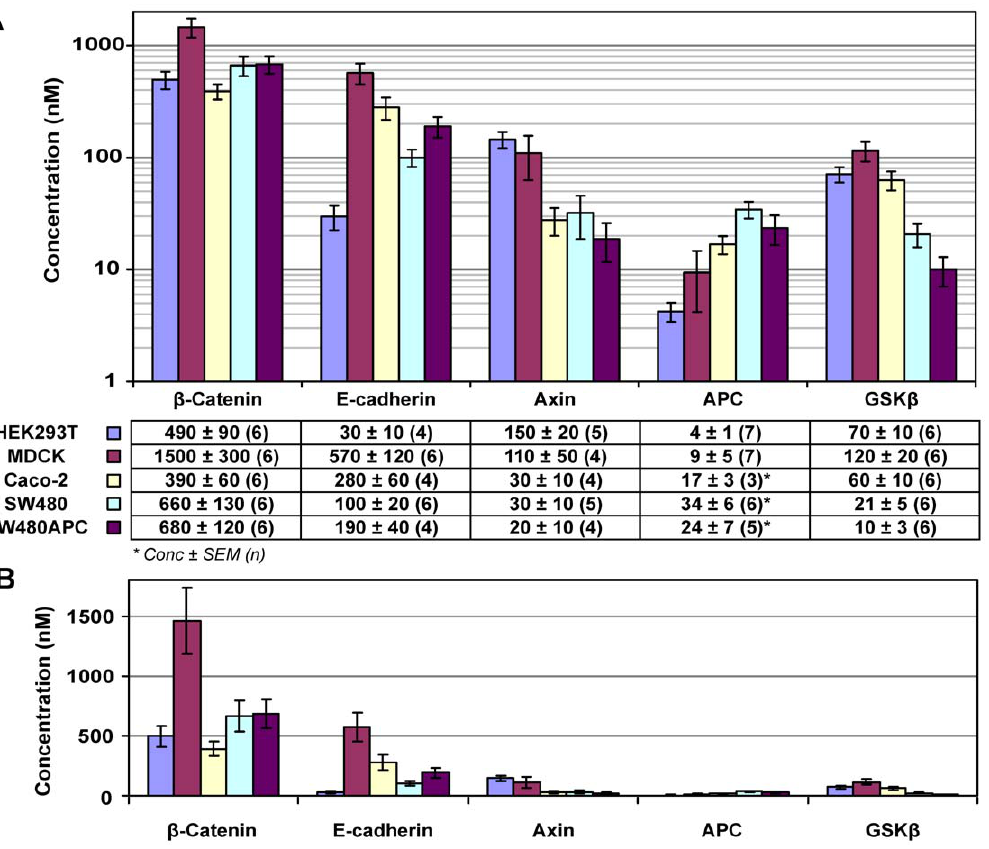
Figure 6. Key protein concentration distribution in mammalian cells. (A) Average concentration of key Wnt proteins and E-cadherin of the five mammalian cell lines. (B) Figure redrawn in linear scale, reiterating the significant difference in concentrations between the proteins measured and the effect of log scales on perception of concentration differences. *Note that the APC measured in Caco-2, SW480 and SW480 are D APC. The amount of wild type APC is too low to be detected and the measurement here is for D APC. In SW480APC, approximately 95% of the total APC is